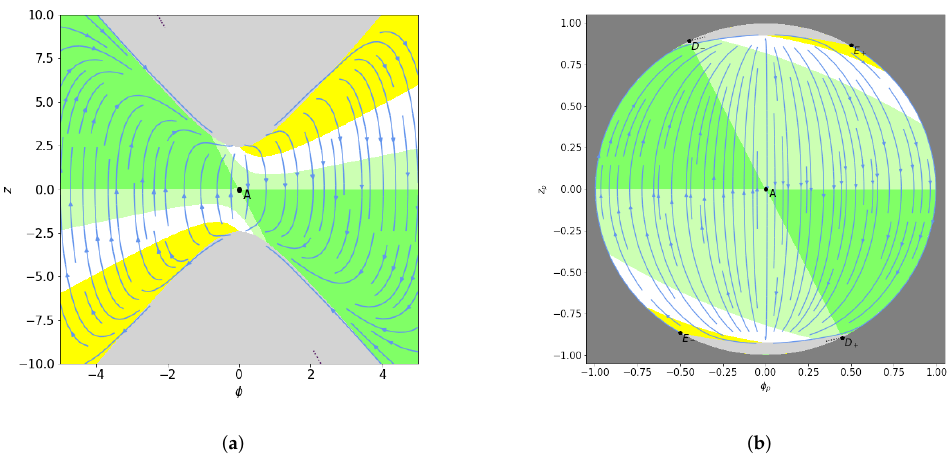
Figure 2. Cosmological dynamics of the quadratic model (31) with Λ = 0, and ξ = 0.5 ( b ), ξ = 1 ( a ). Green background stands for superaccelerated, light green accelerated, white decelerated, and yellow superstiff expansion, while grey covers the unphysical region. Orange trajectories are heteroclinic orbits between the fixed points, the wider red part of the master trajectory highlights the 50 last e-folds of inflation, while red semi-transparent cover shows the basin of initial conditions leading to 50 e-folds. The dotted curve marks where the path of the slow roll approximation would be.